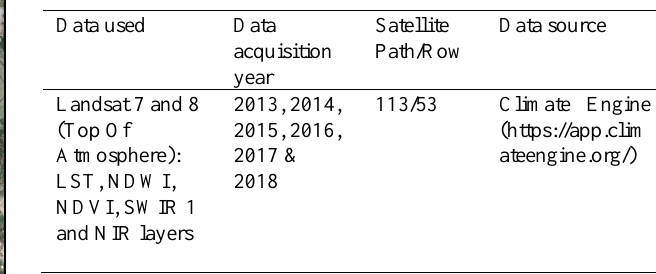
Table 1. Data specification, acquisition and source of satellite images